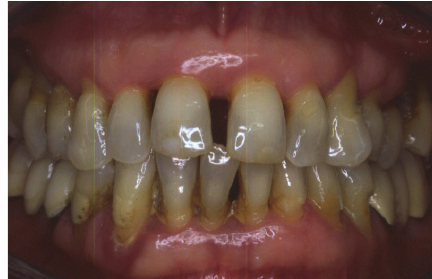
Figure 3: Initial case: lateral view, left side.